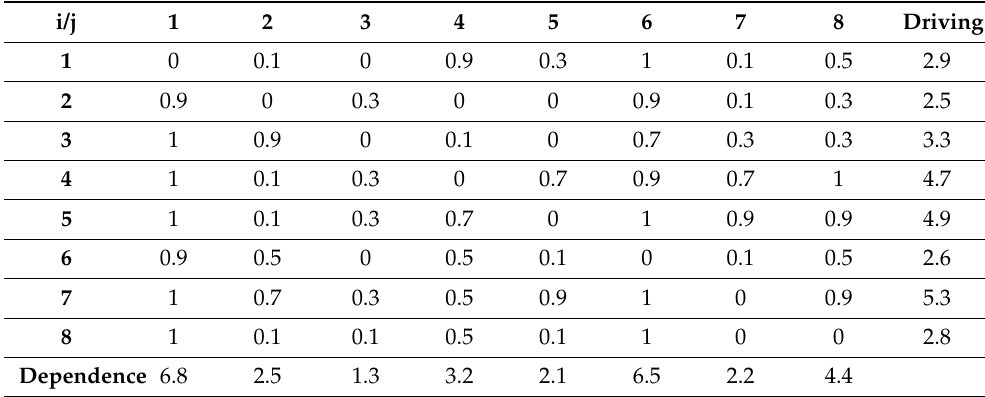
Table 6. Fuzzy MICMAC Analysis.